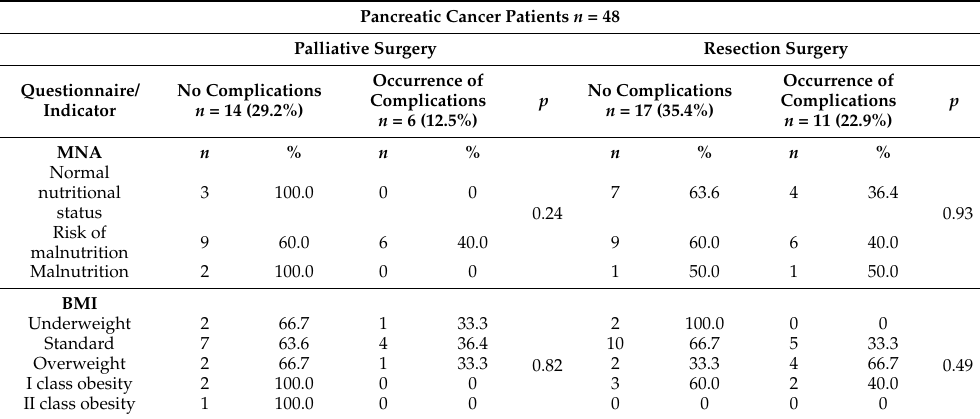
Table 3. Nutritional status of patients with pancreatic cancer before surgery and the incidence of postoperative complications considering the type of surgery. Pancreatic Cancer Patients n = 48 Palliative Surgery Resection Surgery